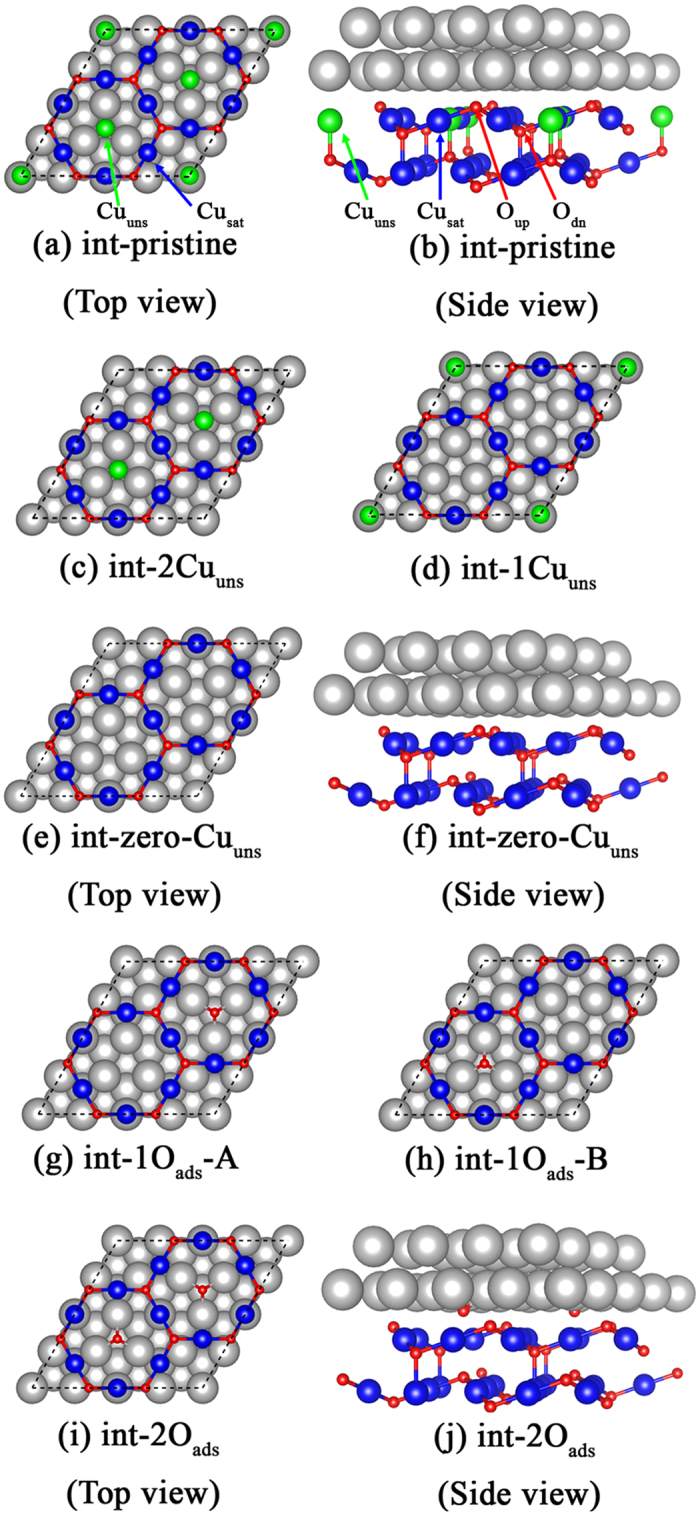
Top and side views of Cu/Cu2O interface with pristine structure, int-pristine in (a) and (b). Part of the interfacial Cuuns atoms present, two and one Cuuns in (c) int-2Cuuns and (d) int-1Cuuns). Top and side views of interface without interfacial Cuuns, int-zero-Cuuns in (e,f). Interfaces with additional adsorbed oxygen atoms based on the int-zero-Cuuns. According to the Oads locations and amount, they are labeled as int-1Oads-A in (g), int-1Oads-B in (h) and int-2Oads in (i,j). Large silver balls are Cu atoms in Cu(111) surface. Green and blue balls denote the Cuuns and Cusat in Cu2O, respectively. Small red balls are oxygen atoms.